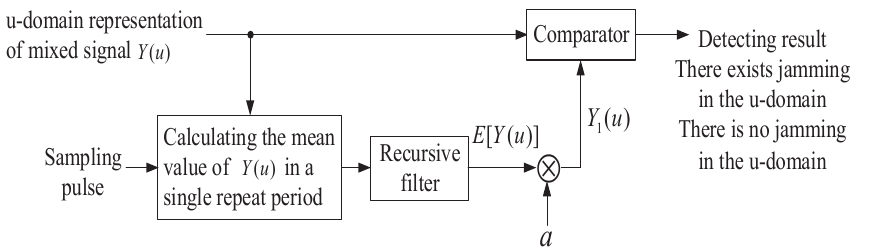
Figure 4. Adaptive threshold CFAR processing in the time-frequency domain.